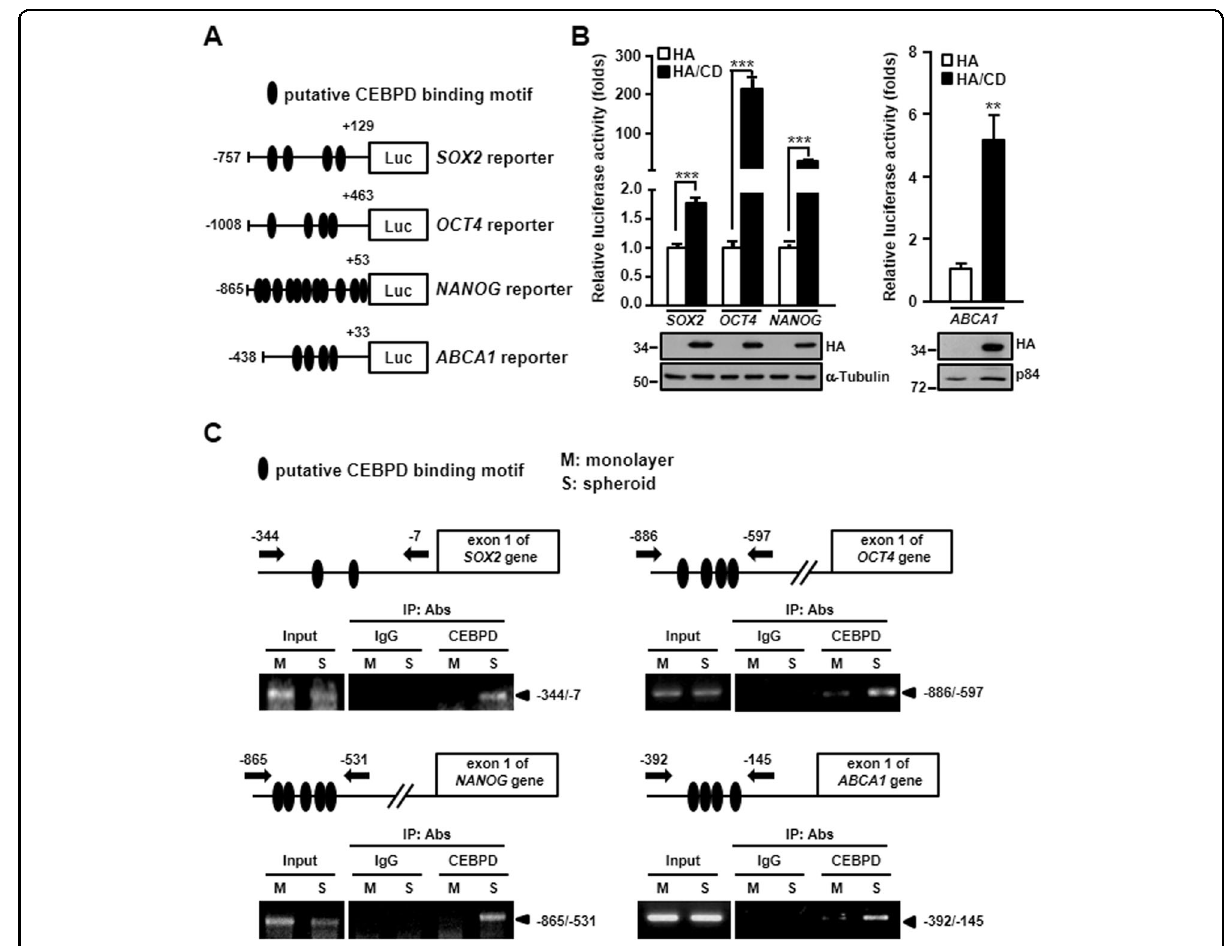
Fig. 5 CEBPD can directly bind to the SOX2, OCT4, NANOG, and ABCA1 promoter regions to regulate gene expression. A Schematic representation of reporter constructs with the SOX2 , OCT4 , NANOG , and ABCA1 promoters. The approximate locations of the putative CEBPD-binding motifs are indicated by ovals. B U87MG cells were co-transfected with pcDNA3-HA or pcDNA3-HA/CEBPD and SOX2, OCT4, NANOG, and ABCA1 reporter vectors and then examined by reporter assay. C CEBPD binds to the SOX2 , OCT4 , NANOG, and ABCA1 promoters in vivo. Chromatins from U87MG monolayer or spheroid cells were isolated, and ChIP assays were performed with the indicated antibodies. The precipitated DNA was ampli fi ed by PCR using speci fi c primers. The summary data are presented as the mean ± SEM; the numbers in the bars represent the sample sizes; Student ’ s t -test; ** p < 0.01, *** p <